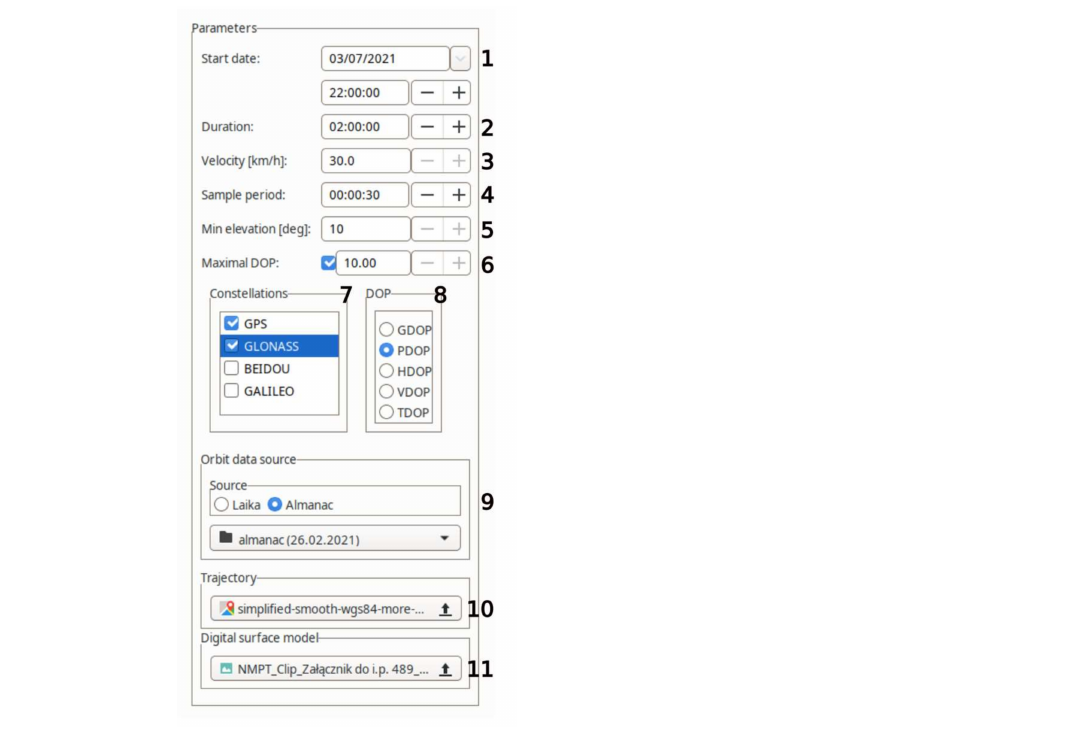
Figure 2. Input parameters of the